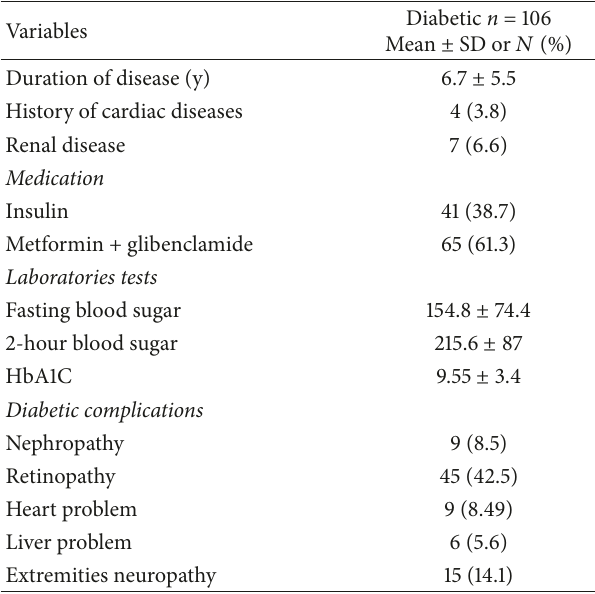
Table 2: The history of chronic disease, medication, and medical complications among diabetic patients.